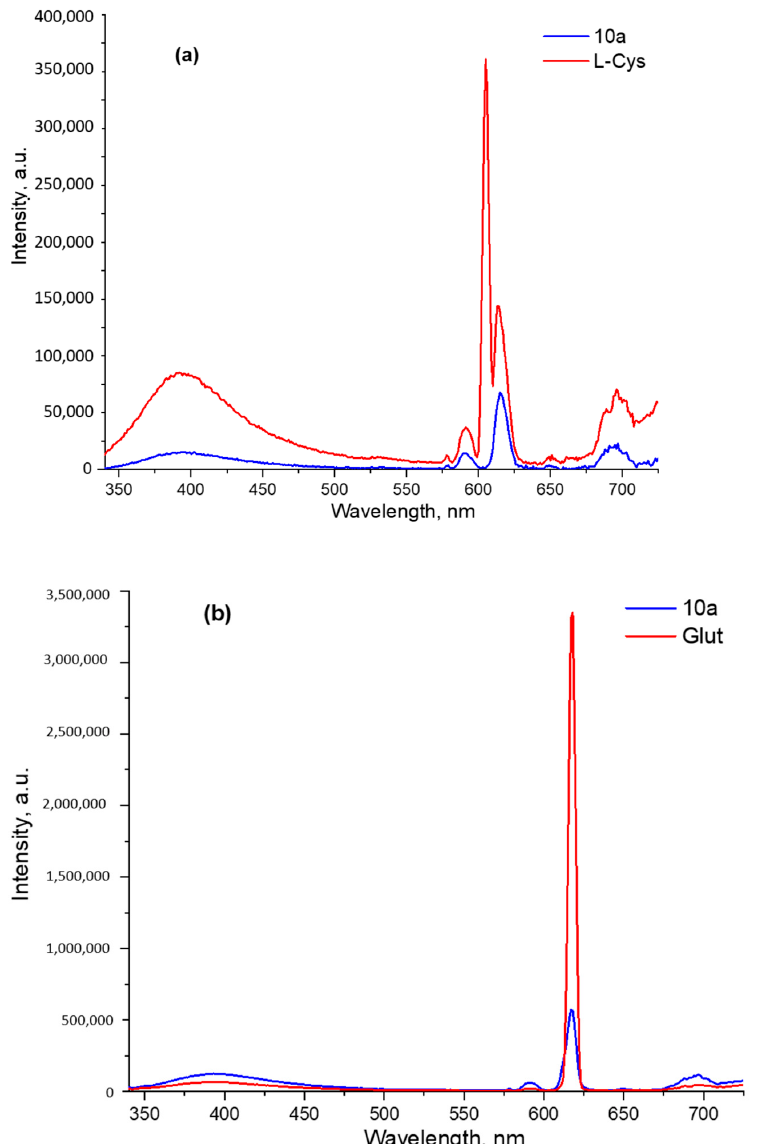
Figure 7 . The emission spectra of solutions of complex 10a and their mixtures with ( a ) L-cysteine and ( b ) glutathione .